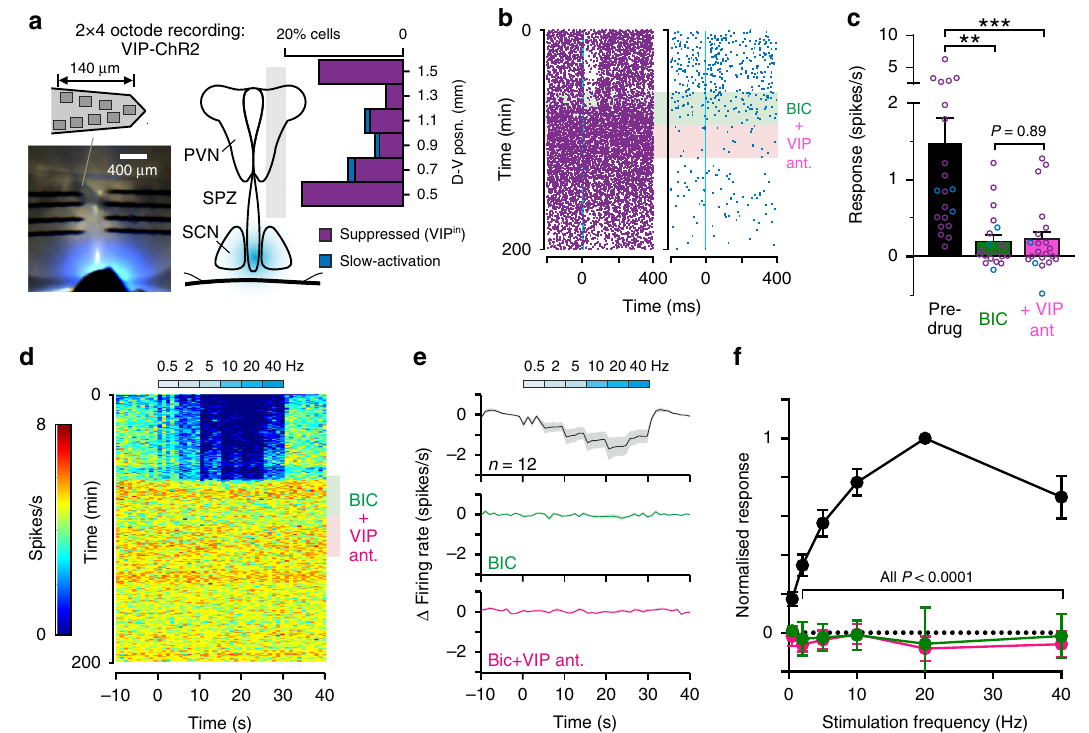
Fig. 4 Suprachiasmatic nucleus VIP neurons drive GABA-mediated responses in downstream target neurons. a Slice image and schematics (left) illustrating 2 × 4 octode probe placement and position of fi bre-optic delivered light fl ash. Right panel shows the percentage of identi fi ed cells displaying suppressions or slow-activation following 10 ms light fl ashes (in total n = 37 and 3 cells respectively from 561 isolated neurons), from ex vivo recordings across the SPZ, PVN and ventral thalamus of VIP-ChR2 mice. b Peri-event spike raster plots for representative VIP in (supressed) and cells with slow- activation prior-to and following BIC application and subsequent co-application with VIP antagonist. c Mean ± SEM optogenetically-evoked change in fi ring rate of individual cells prior to and following antagonist treatment ( n = 18 VIP in and n = 3 cells with slow-activation). Data analysed by multilevel mixed- effects linear model (Treatment: F 2,24.521 = 8.44, P = 0.002) with Tukey ’ s post-tests. d , e Pseudo-coloured spike raster for representative VIP in cell ( d ) and mean ± SEM baseline-subtracted fi ring rates across the population ( e ; n = 12 cells) during exposure to repeated stimulation (10 ms fl ashes) at varying frequencies, prior to and following antagonist treatment as above. f Mean ± SEM normalised change in fi ring (relative to no stimulation) for VIP in cells ( n = 12) as a function of optogenetic stimulation frequency during pre-drug and antagonist treatment conditions. Data analysed by multilevel mixed-effects linear model (Frequency: F 5,21.785 = 6.99, P < 0.001; Treatment: F 2,20.357 = 49.72, P < 0.001; Interaction: F 10,23.401 = 16.71, P < 0.001) with Sidak ’ s post-test. *** P < 0.001, ** P <